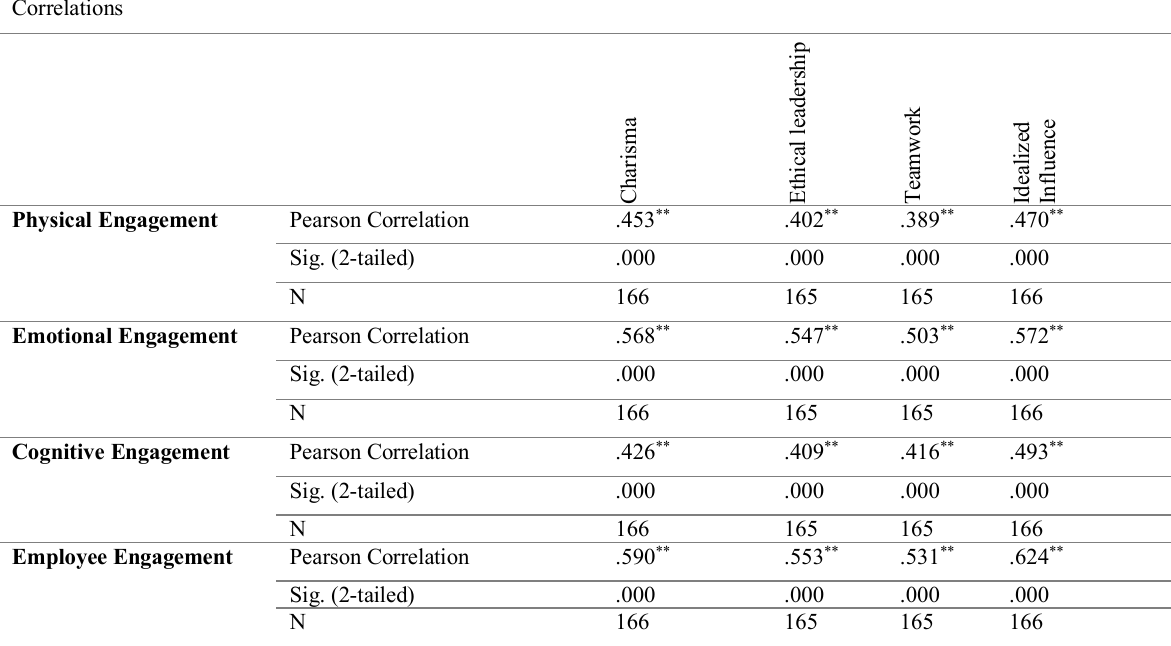
Table 1: Correlations between Idealized Influence and Employee Engagement Correlations